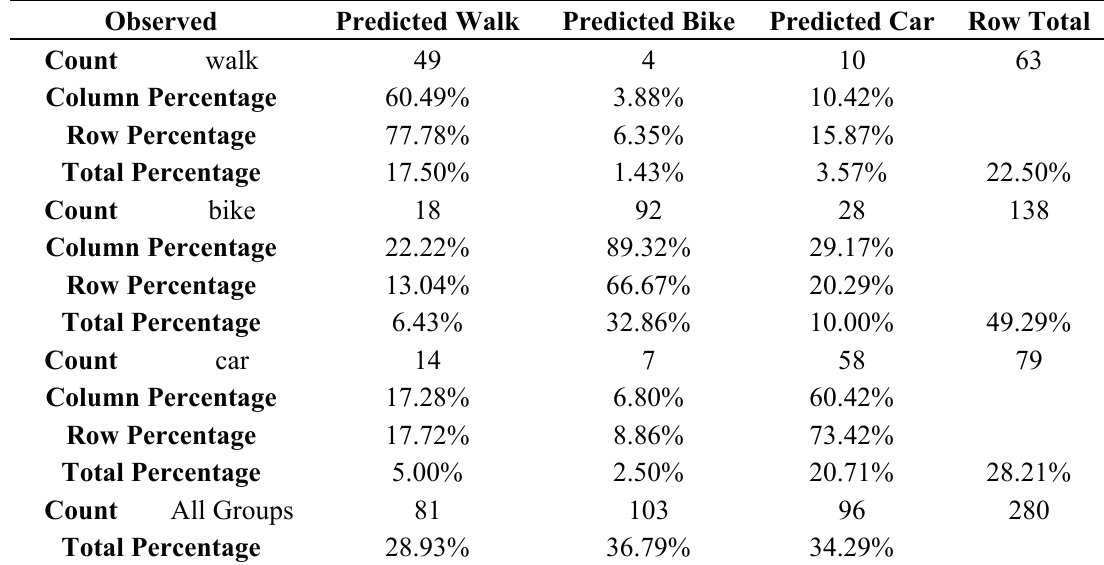
Figure 4. Classification matrix histogram. Table 4. Classification matrix